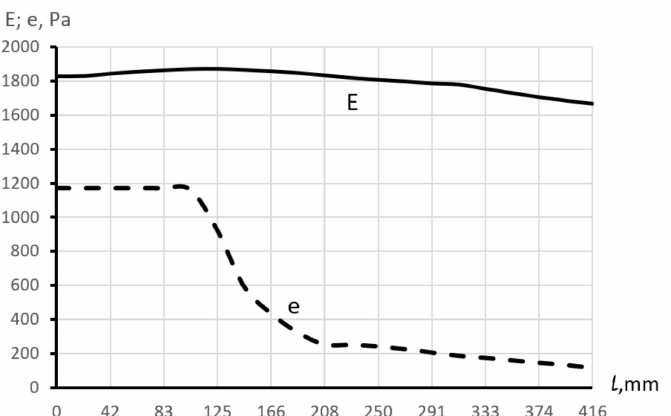
Figure 21. Graphs of changes in the partial pressure of water vapor e and partial pressure of saturated water vapor E in the area of metal structures that are not in contact with the attic air for calculation scheme with a gusset plate (thermal insulation—mineral wool with a density of 200 kg/m 3 and a thickness of 100 mm).